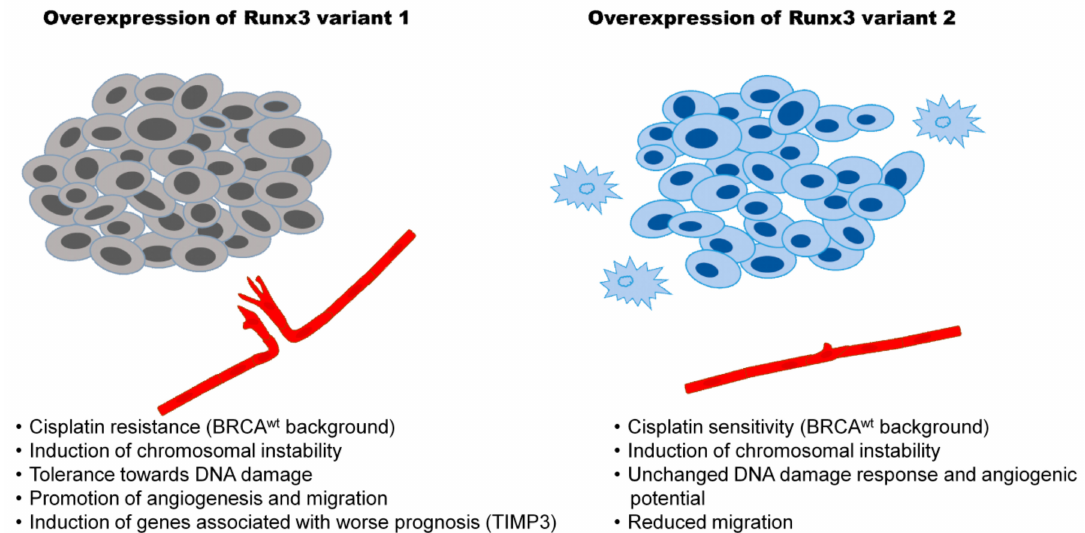
Figure 7. Postulated mode of action of RUNX3 transcript variants. Whereas present and published data [7] point to TV1 as mediating properties linked to aggressive tumor behavior, TV2 induces phenotypic changes compatible with improved patient